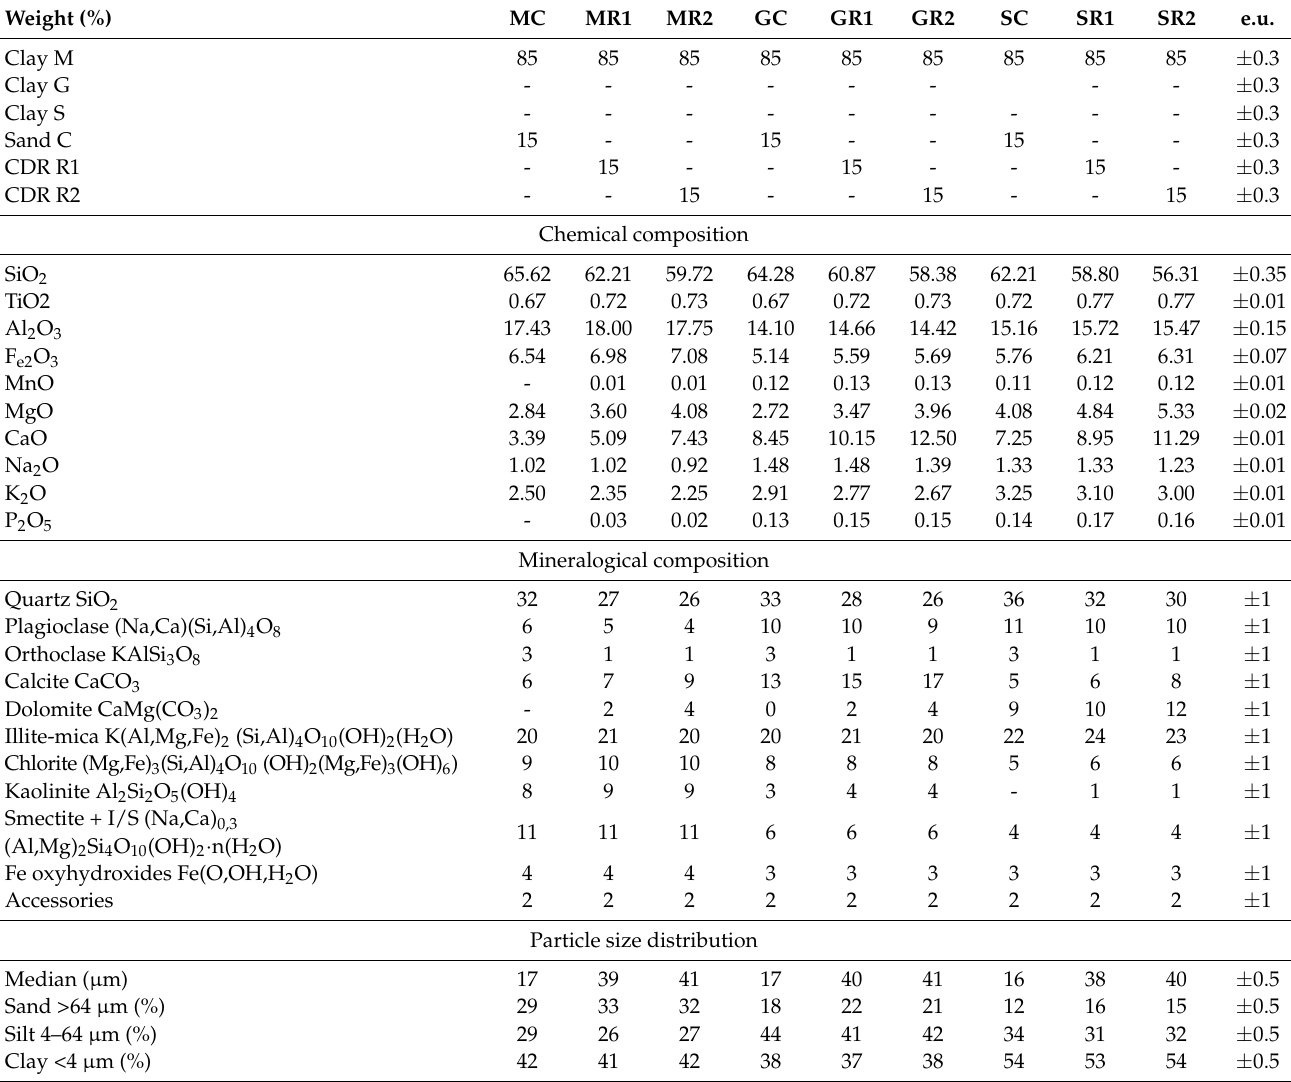
Table 2. Formulation, chemical and mineralogical composition, and particle size distribution of the